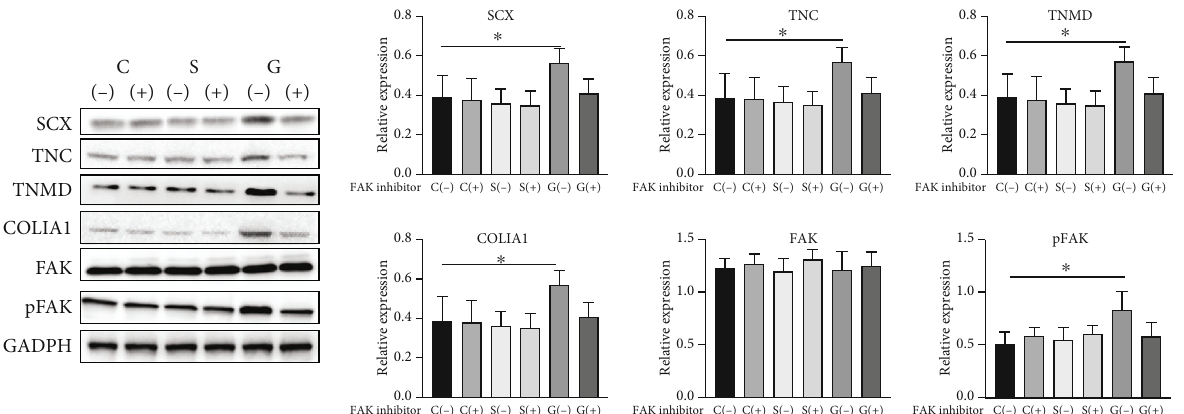
Figure 6: Western blot analysis of the protein expression level of SCX, TNC, TNMD, COLIA1, FAK, and pFAK, and GAPDH was used as the loading control; n = 3 , ∗ P < 0 : 05 , and ∗∗ P < 0 : 01